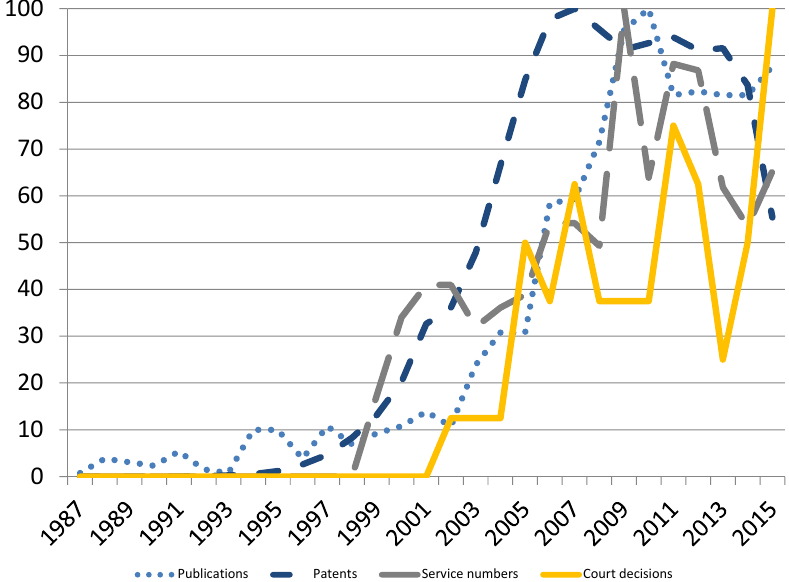
Fig. 4. Normalized time-series of different